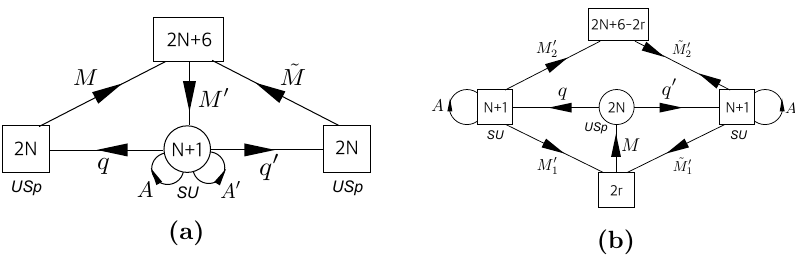
Figure 3. Figure (a) is the domain wall connecting two 5 d USp(2 N ) gauge theories with (cid:13)ux ( 1 ; 1 ; ; 1 ). Figure (b) is the domain wall connecting two 5 d SU( N + 1) gauge theories with 2 2 2 (cid:1) (cid:1) (cid:1)